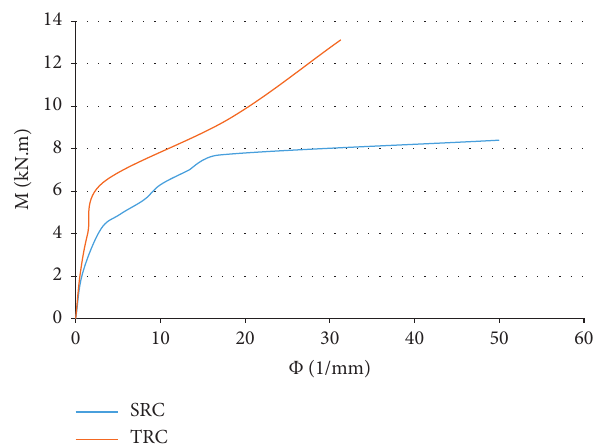
Figure 8: Moment curvature of TRC and SRC